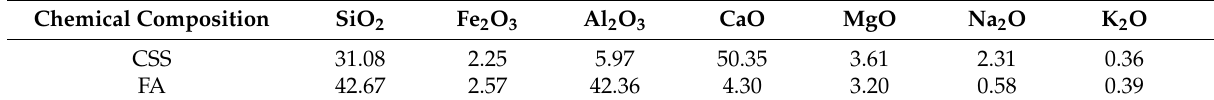
Table 1. Chemical composition of CSS, FA (wt.%).